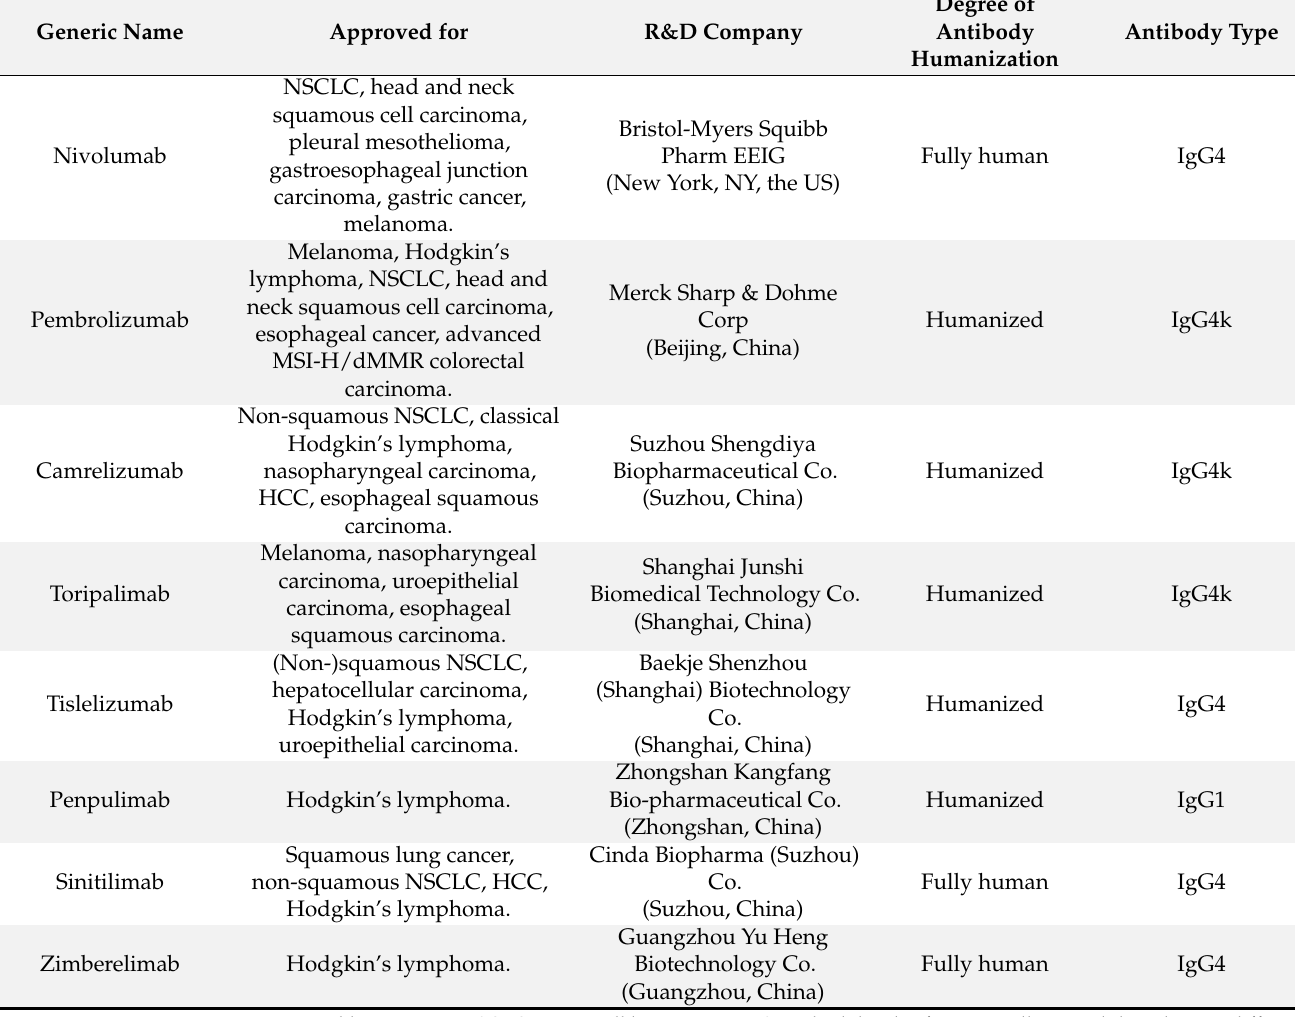
Table 2. PD-1 inhibitors currently in use for clinical treatment.